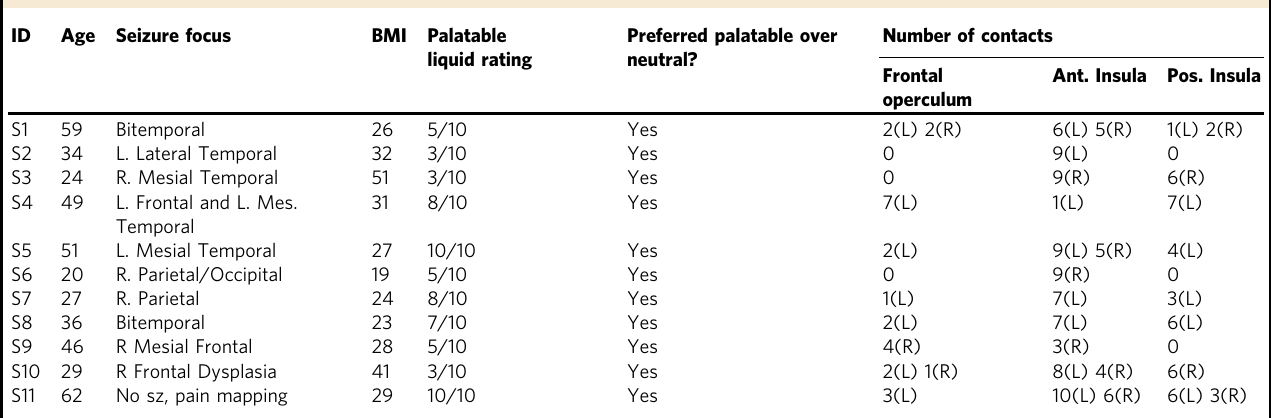
Table 1 Participant